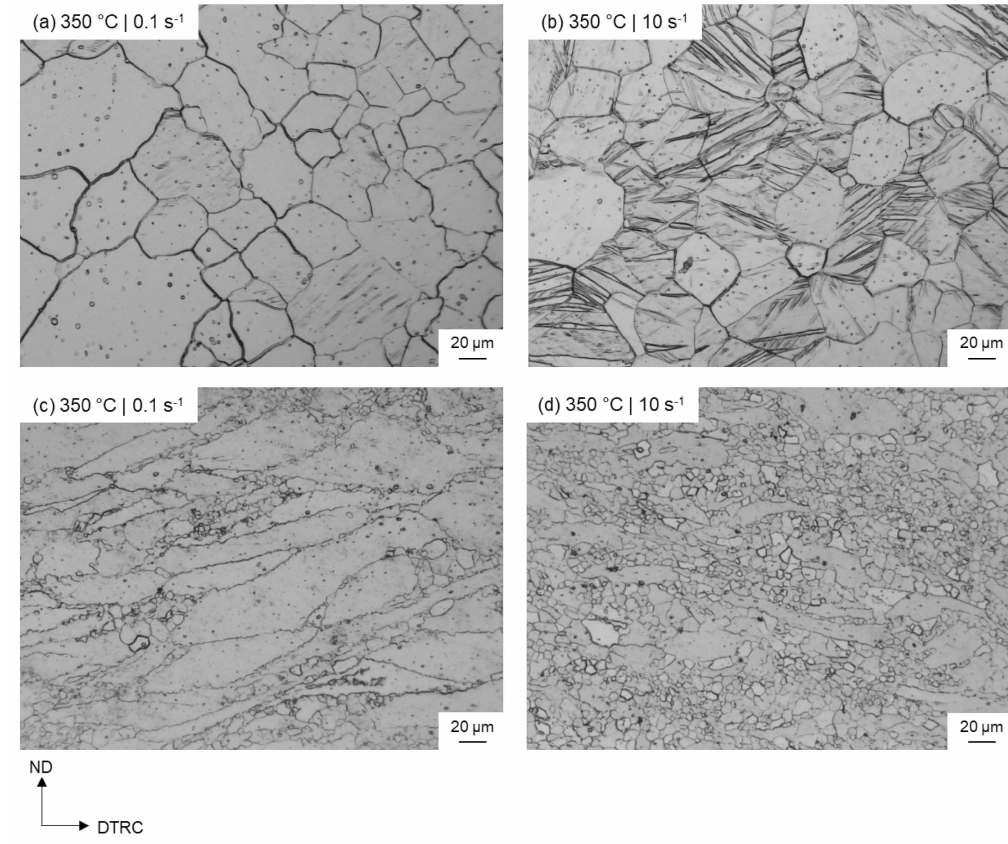
Figure 3. Optical micrographs of the ZAX210 alloy after plane strain compression at 350 ◦ C under a strain rate of ( a ) 0.1 s − 1 and ( b ) 10 s − 1 and an equivalent logarithmic strain of 0.2, and ( c ) 0.1 s − 1 and ( d ) 10 s − 1 and an equivalent logarithmic strain of 0.6.